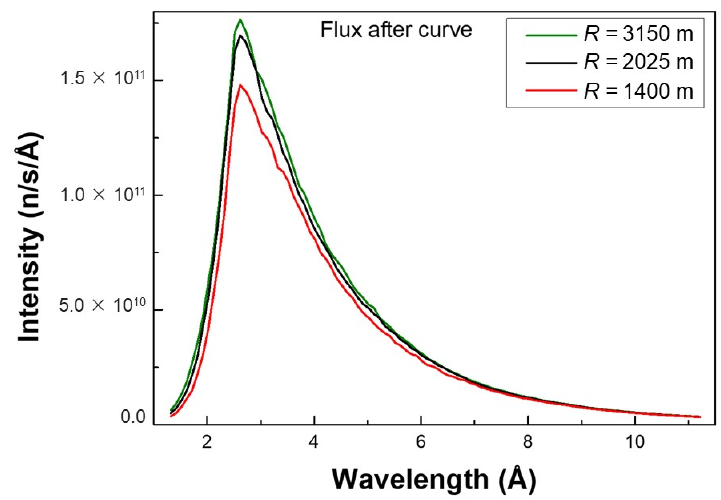
Figure 5. Spectral intensity distribution for the curved guide options described in the text.